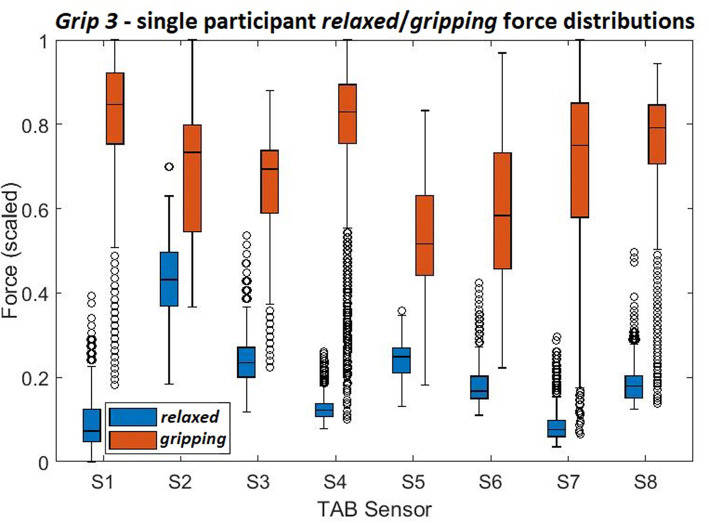
The force density distributions, relaxed and gripping, from a single participant's data when performing Grip3.